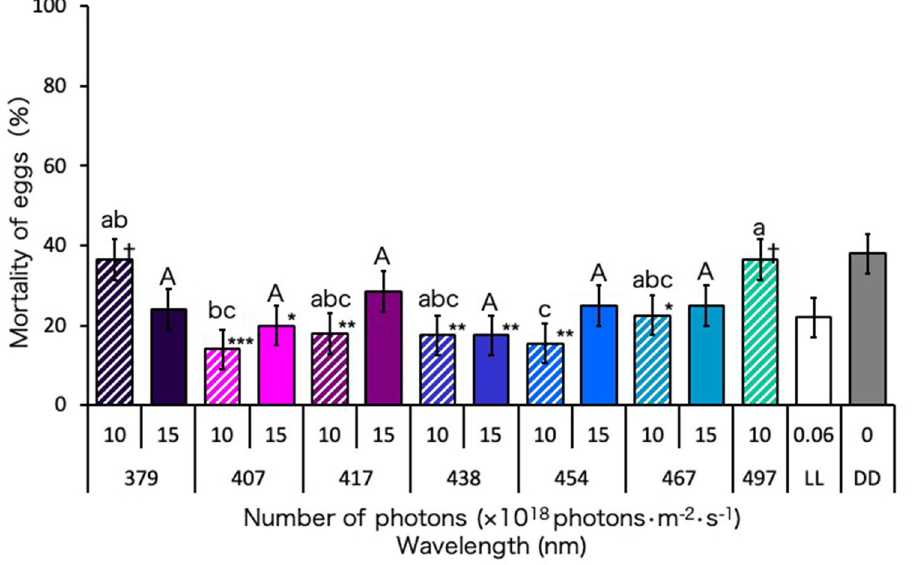
Figure 1. Mortality of Aedes albopictus irradiated with blue light during the egg stage. Data represent the means ± standard errors. Asterisks above the bars indicate significant differences between the treatments (UVA and blue light irradiation) and control [dark condition (DD)] (Steel test: * p < 0.05, ** p < 0.01, *** p < 0.001). Daggers above the bars indicate significant differences between the treatments (UVA and blue light irradiation) and the control [continuous white light condition (LL)] (Steel test: † p < 0.05). Bars with the same letters are